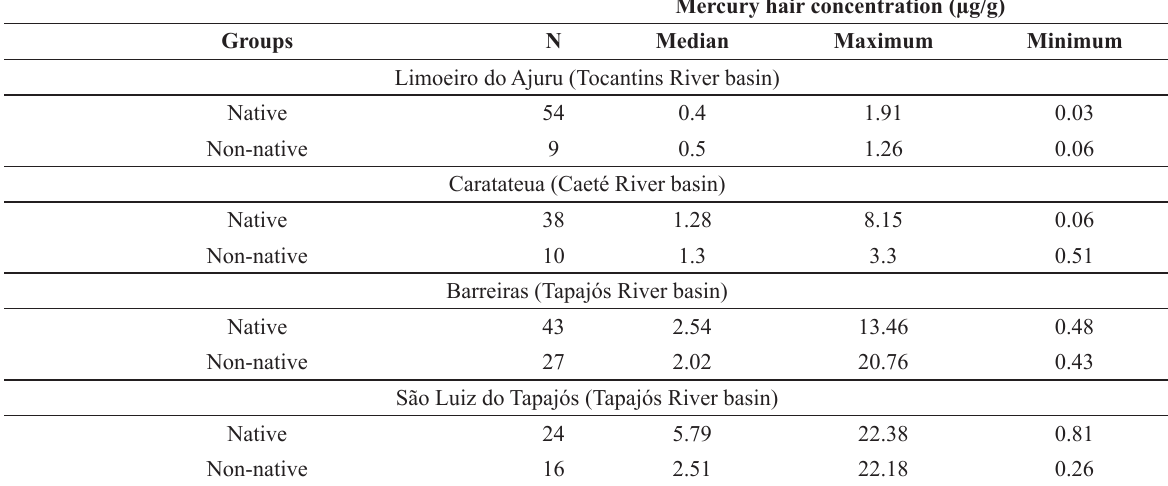
Mercury hair concentration from native and non-native children from riverine communities of different river basins in Brazilian